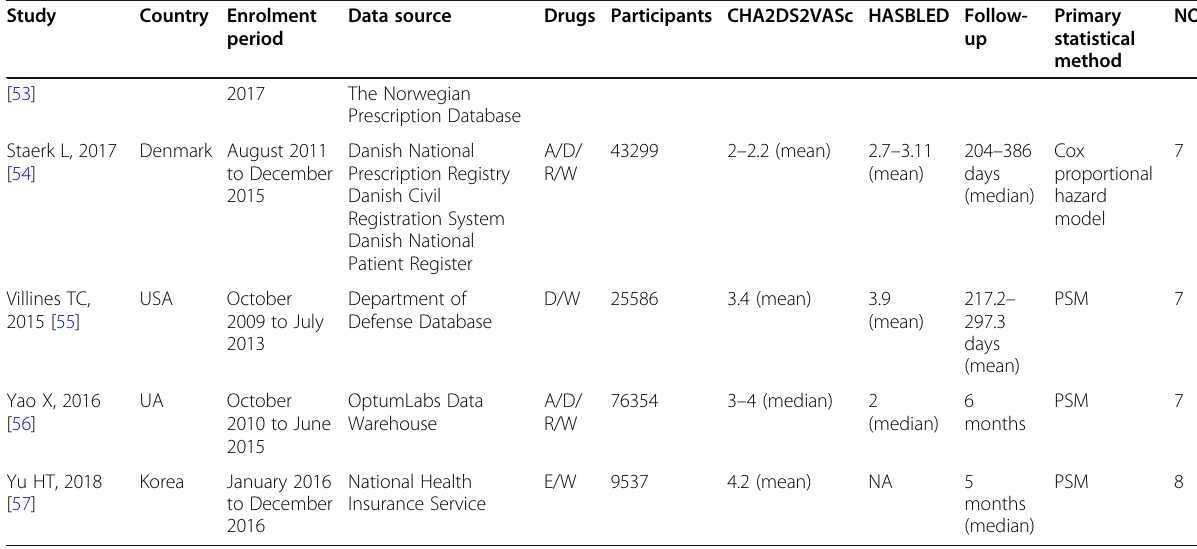
Table 1 Baseline characteristics of the studies (Continued)